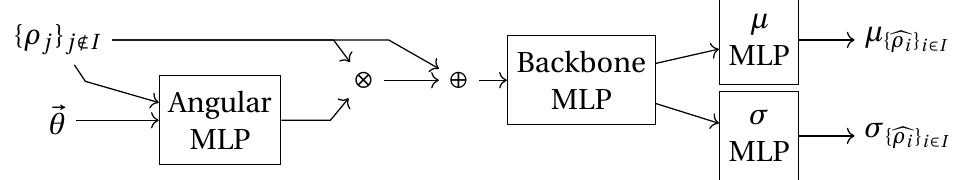
Figure 4. Overview of the nonlinear regression of a set of spectral bands using other bands and angular information as predictors assuming a Gaussian error model.